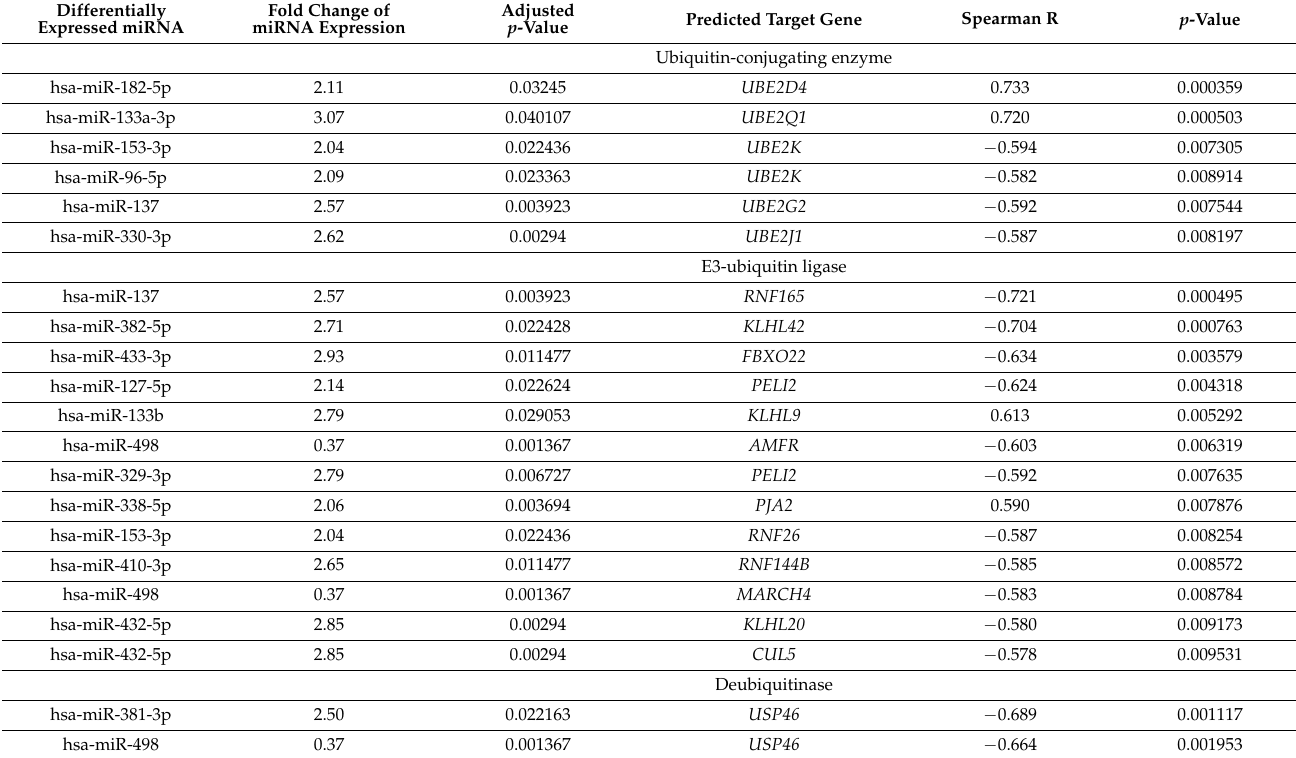
Table 3. The list of protein ubiquitination-related genes regulated by differentially expressed miRNAs (according to target prediction and correlation analysis) that were commonly found in the significantly enriched process in GSE analysis. The results of the correlation analysis between miRNA and predicted target mRNA levels and the results of miRNA differential analysis of USP8 mut and USP8 wt